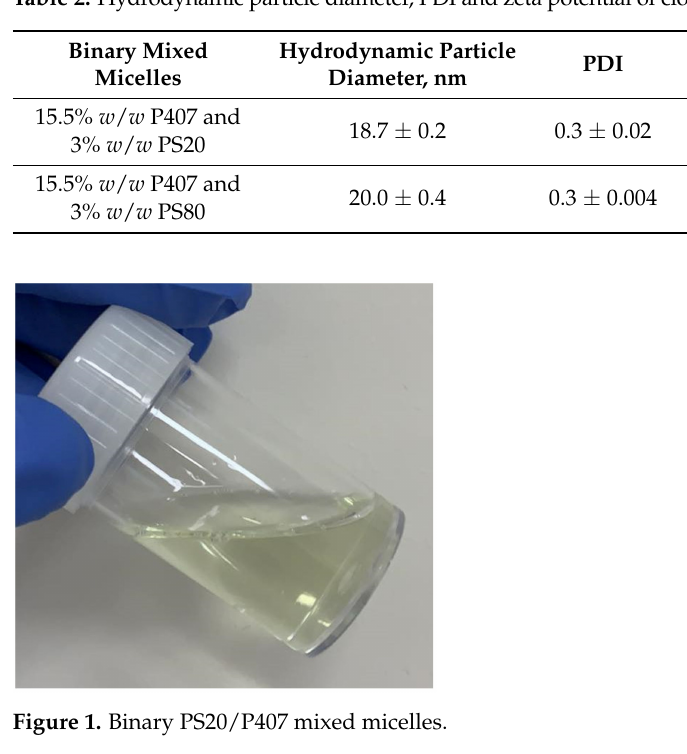
Table 2. Hydrodynamic particle diameter, PDI and zeta potential of clozapine in binary mixed micelles.